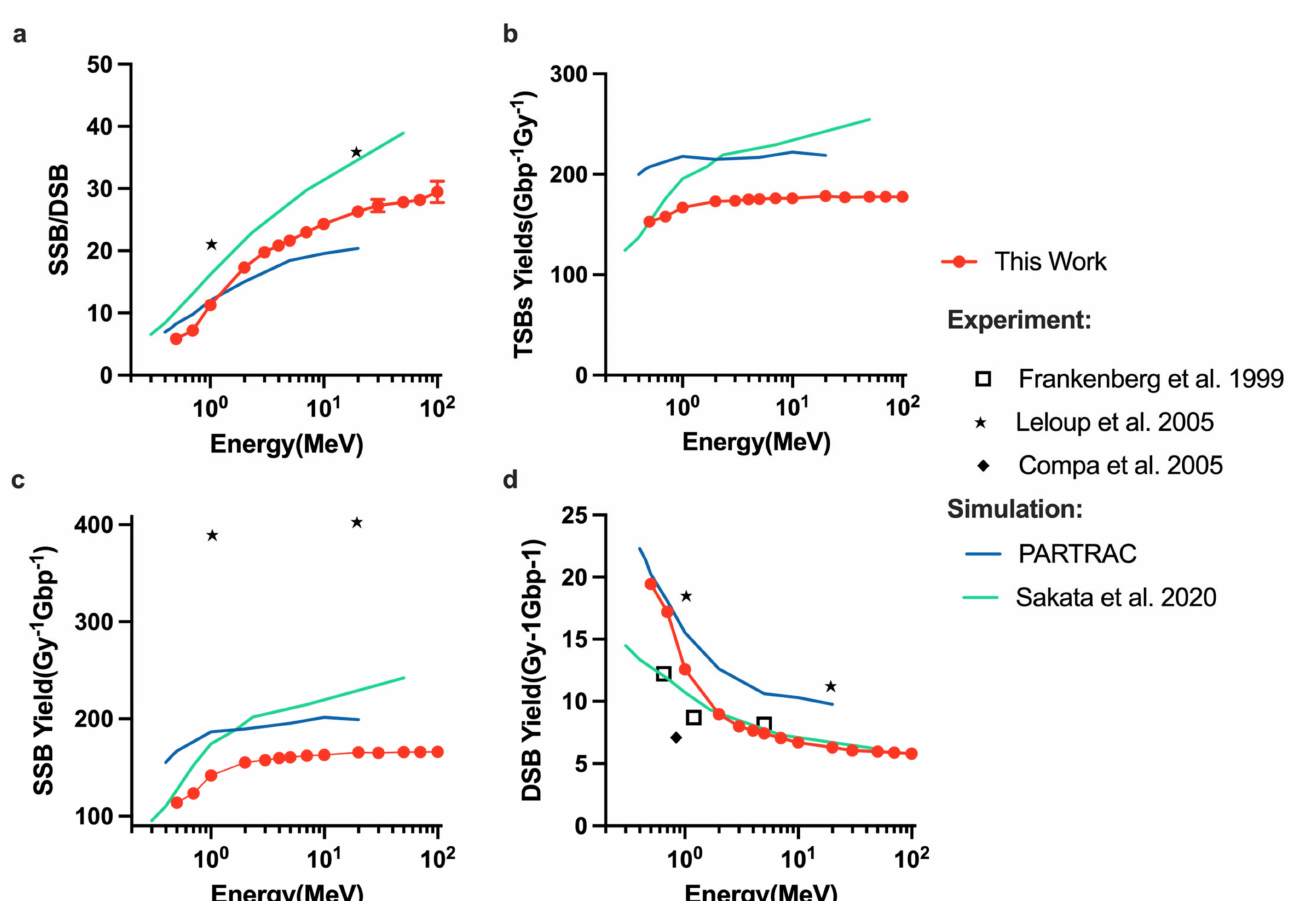
Figure 4. Comparison of results for DNA damages obtained with Geant4-DNA with the experiment data adapted from Ref. [7] Leloup et al., 2005, Ref. [71] Frankenberg et al., 1999, and Ref. [72] Compa et al., 2005, and the simulated data adapted from Ref. [19] Friedland et al., 2010, and Ref. [70] Sakata et al., 2020. All simulations in this work used option2ELSEPA and the linear proportional model. ( a ) The ratio of SSB yield to DSB yield. ( b ) Total strand break (TSBs) yield for protons. ( c ) Total SSB yields for protons. ( d ) Total DSB yields for